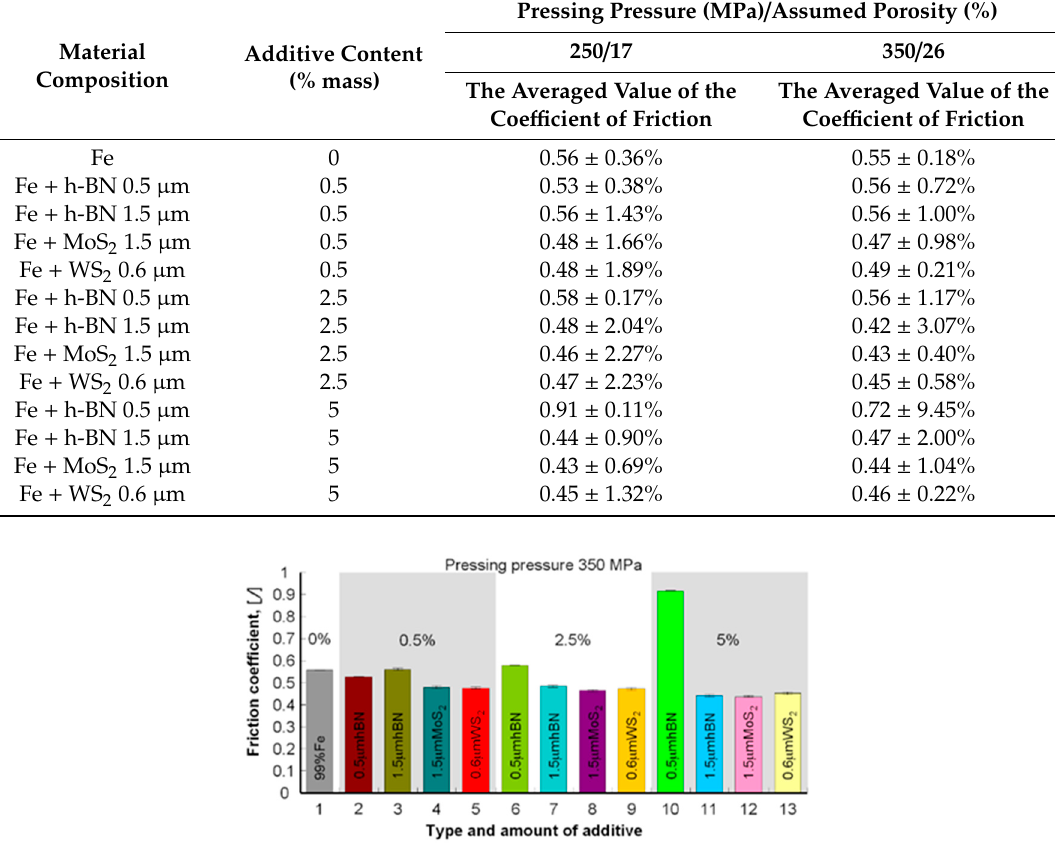
Table 8. Results of tribological tests.